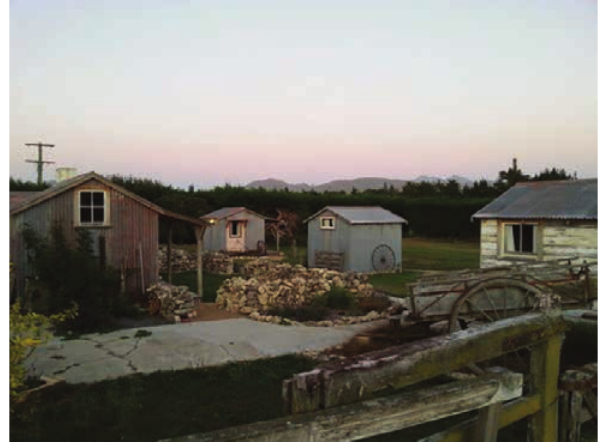
Figure 4: Glamping cottages constructed using recycled farm materi- als, Waitaki District, South Island, New Zealand. Image provided by Author (Tracy